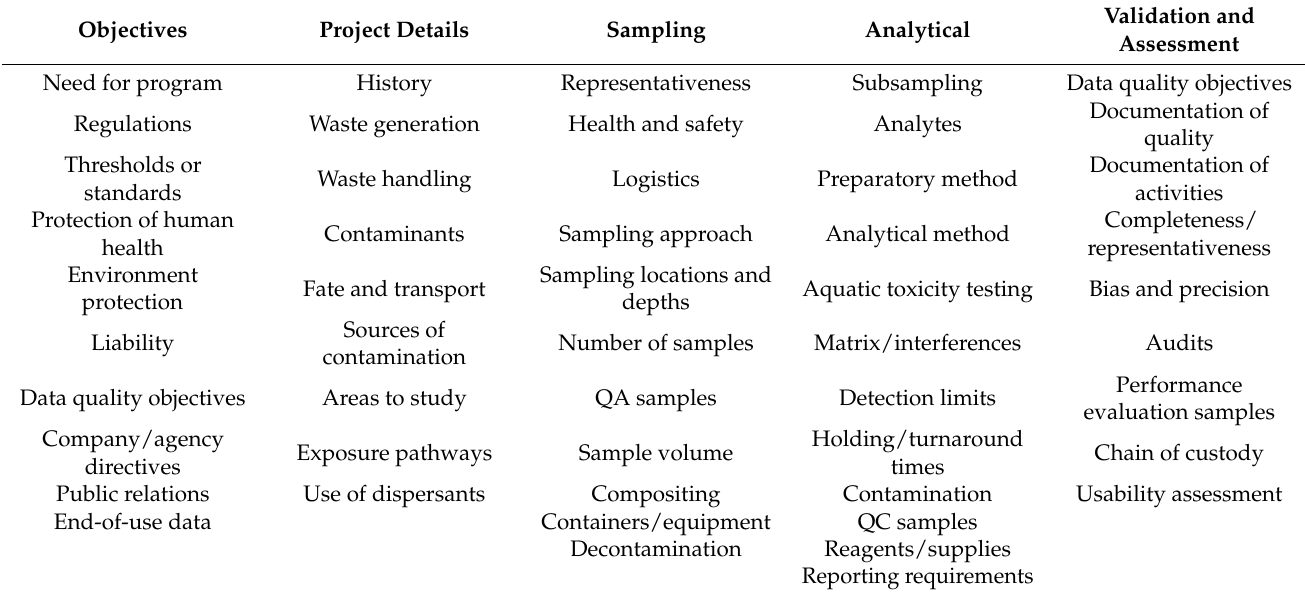
Table 1. Considerations in Planning a Mineral Oil Spill Measurement